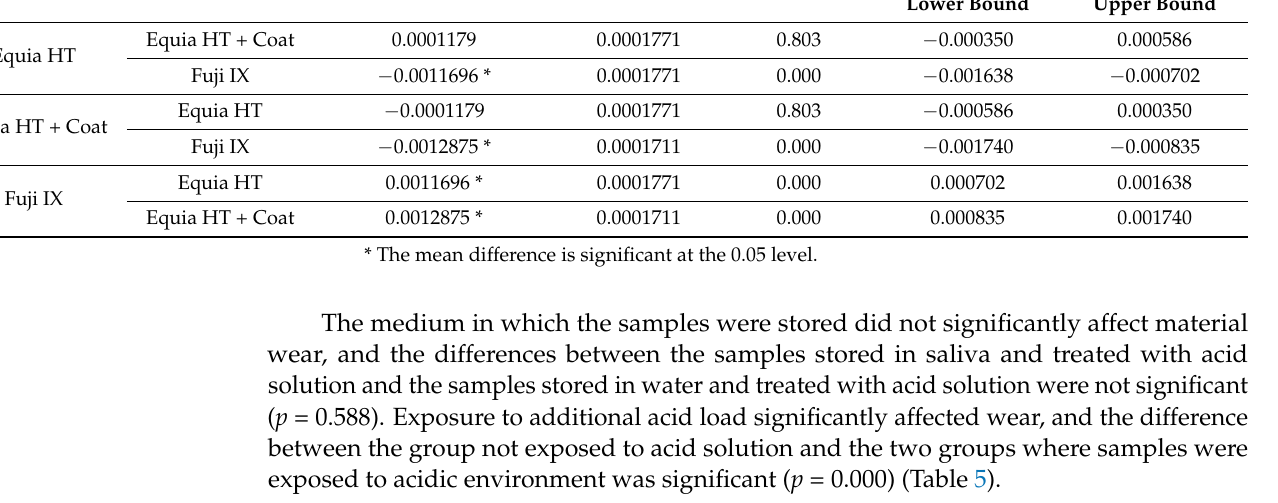
Table 5. Analysis of the influence of storage media and additional acid load on the wear of the samples. (I) Acid